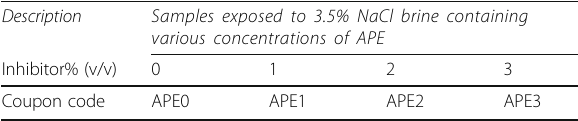
Table 1 Composition of the steel samples Type of